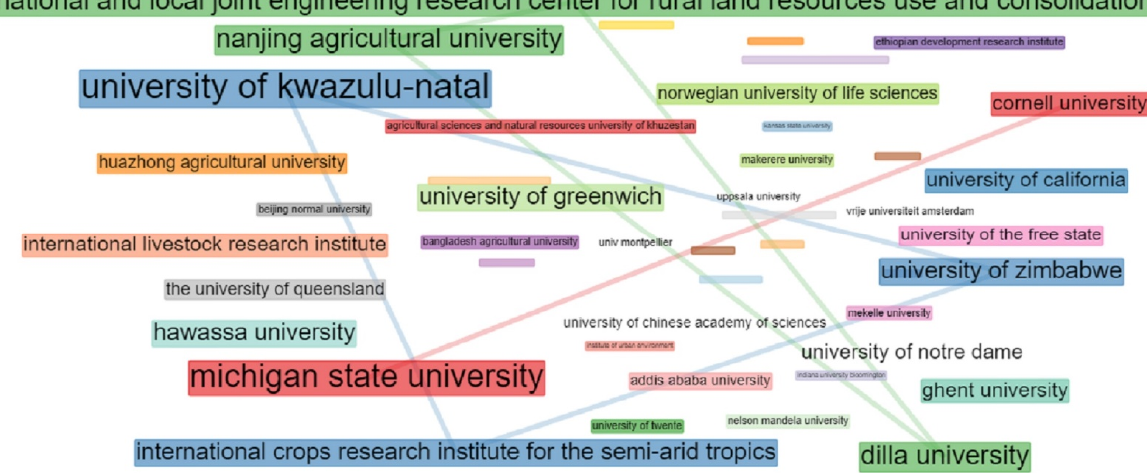
Figure 7. Collaboration network for the top 50 institutions in PASSFDR studies indexed in Scopus from 2011 to 2020.